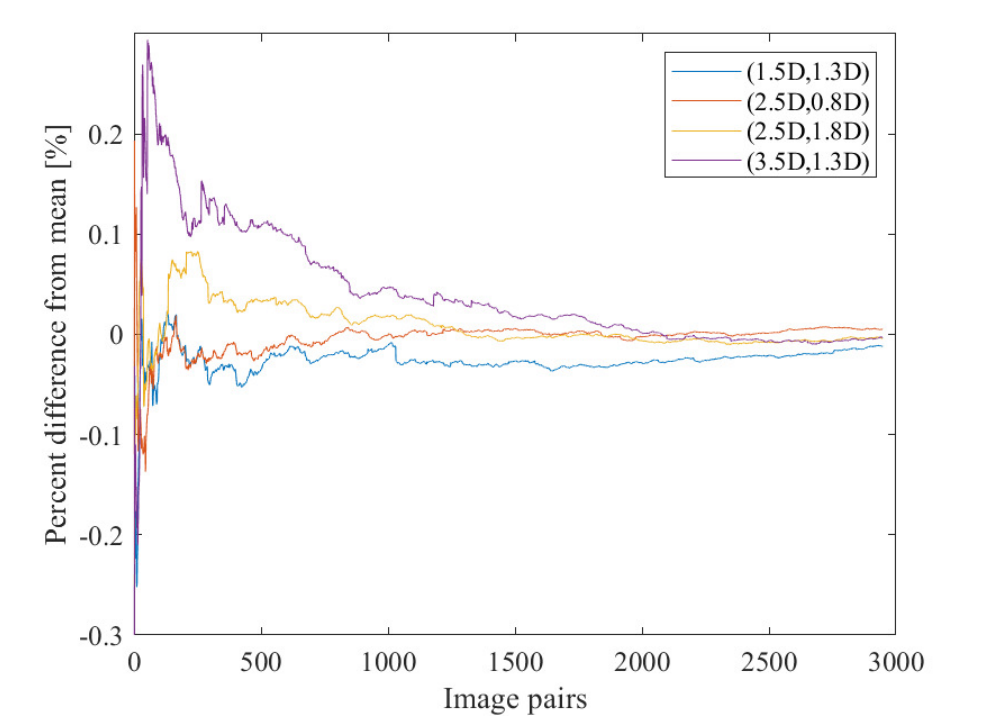
Figure 9. The percent differences of the running averages from the final averages of four points in the flow field. Coordinates of the points can be seen in Figure